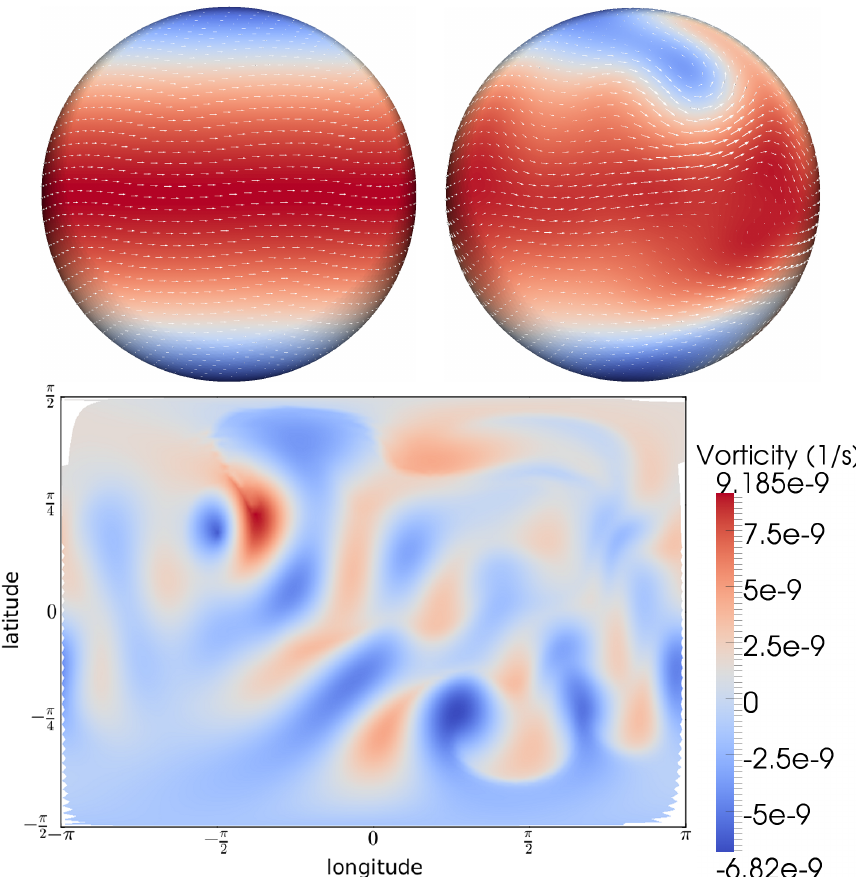
Fig. 15. Snapshots of the solution to test case 5 for the nonlinear shallow water equations at 15 days. These were obtained using the method of Sect. 5.5, with APVM stabilisation. We took E = CG 2 ⊕ B 3 , V = BDFM 2 and Q = DG 1 . Top: initial surface height field, D + b , and velocity field, u ; final surface height and velocity fields. Bottom: final vorticity field, ζ , projected from a triangular mesh into latitude– longitude